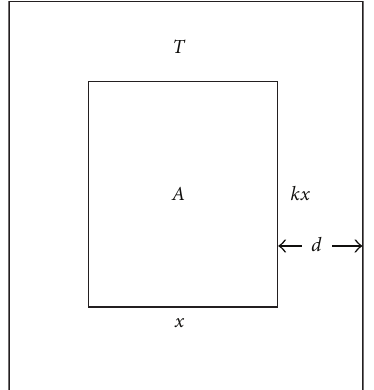
Figure 3: Dimensions of the area under control: A is the core area; T is the total rectangle (core + bu ff er); x is the width of the A area; kx is the length as a multiple of the width; d is the width of the bu ff er zone ( B ) ( B = T − A